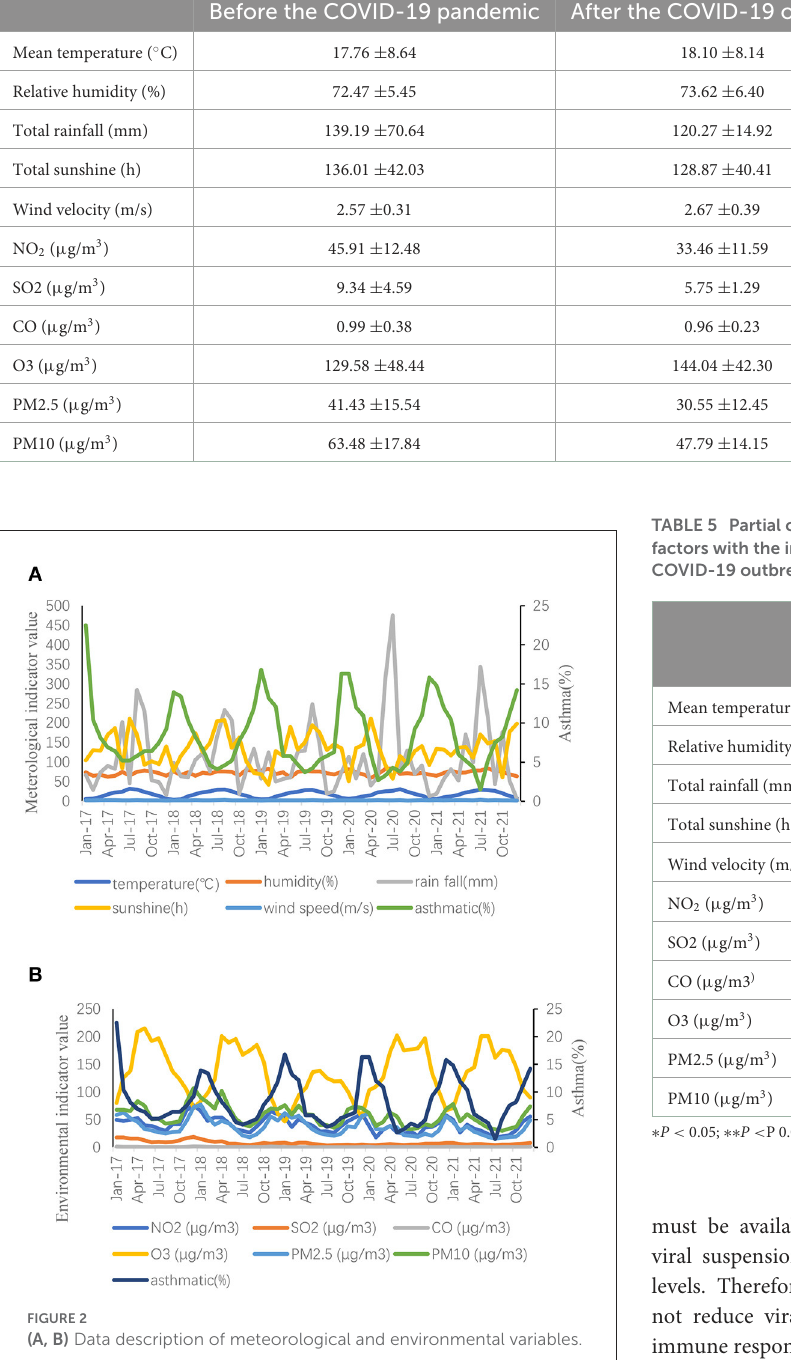
diseases (fibrosis) (29, 30). Children exposed to high concentrations of NO 2 are more likely to suffer from respiratory diseases, especially virus-induced asthma (23).